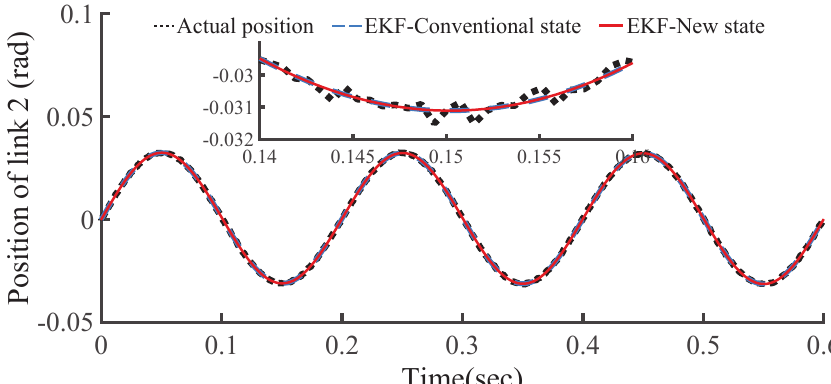
Figure 8. Position estimated by EKF of link 1.